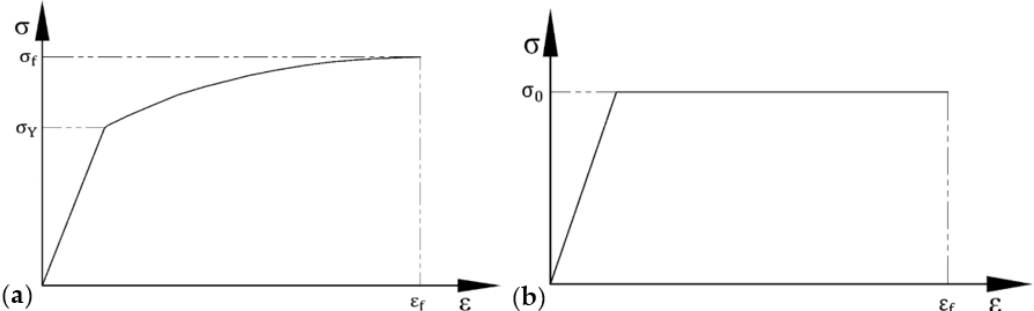
Figure 2. Tensile stress–strain curves of ductile materials: ( a ) typical ductile material with strain-hardening in the plastic region; ( b ) elastic perfectly plastic model of the equivalent material.